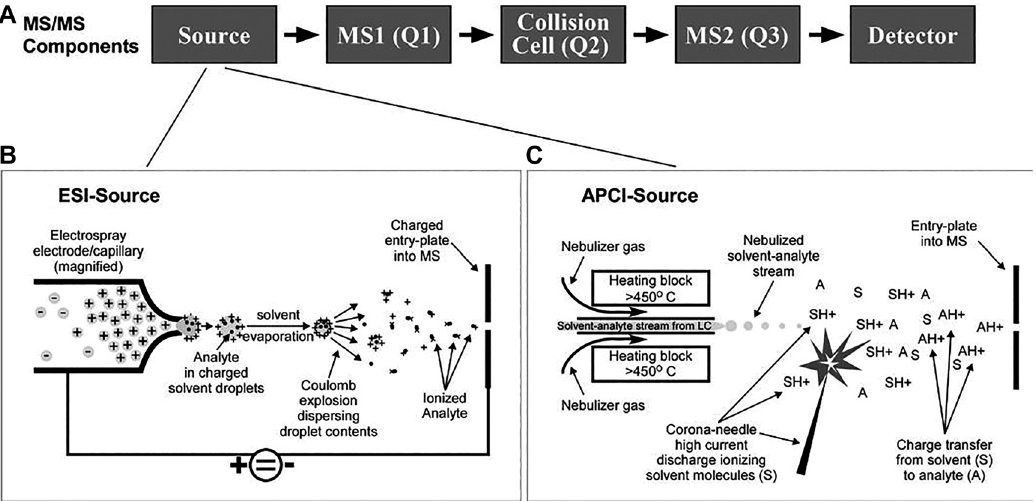
Figure 1: Ionization techniques in mass spectrometry. With permission from ref.